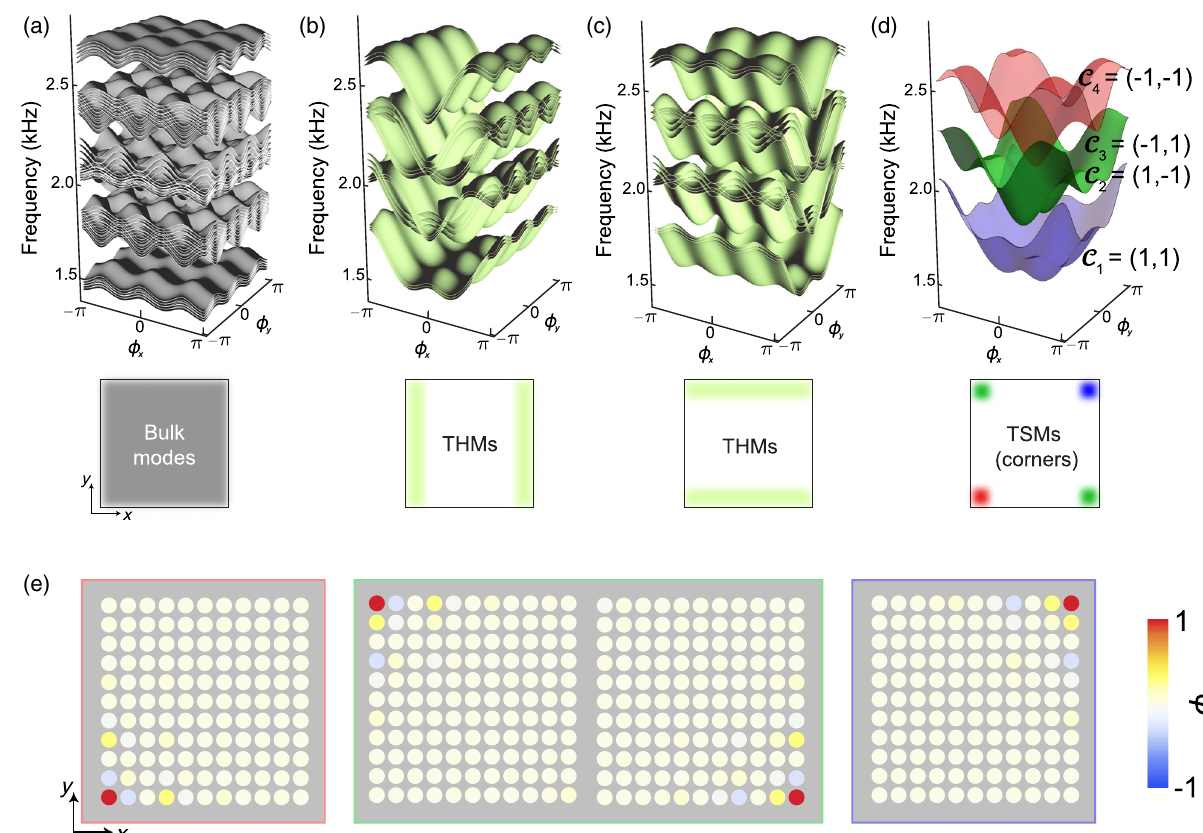
FIG. 2. Second-order gapless TSMs in a 4D Chern insulator. (a) 4D bulk modes occupy all four dimensions. Their eigenspectra are shown as functions of ð ϕ x ; ϕ y Þ , and they appear as 2D bulk modes in the real space (lower). (b),(c) The THMs appear in the gaps of bulk bands and live on the k y ϕ x ϕ y and k x ϕ x ϕ y hyperplanes, respectively. They are localized on the edges in the real space. (d) The TSMs are found closing the THM gaps. The TSMs are 2D modes existing on the ϕ x ϕ y plane; therefore, they are observed as 0D TCMs localized at the corners in the real space. The TSMs are colored to indicate their respective locations. Note that the green sheets are two doubly degenerate states. (e) Real-space eigenfunctions of the four TSMs. The lattice here contains 11 × 11 sites, which is the same as the acoustic system. All results here are obtained using a tight-binding